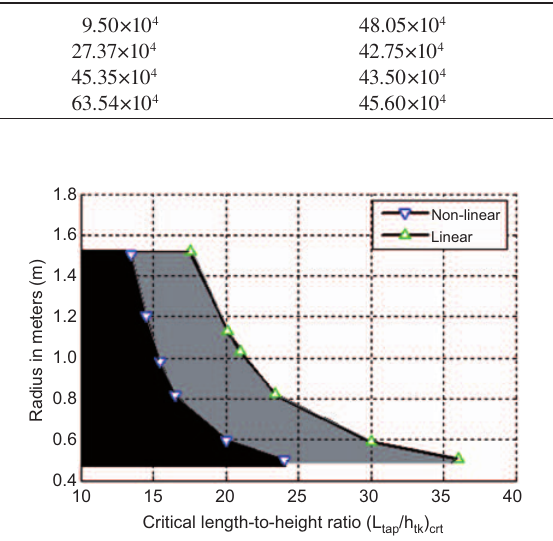
Figure 4 The effect of the radius of the tapered curved composite plate on the critical length-to-height